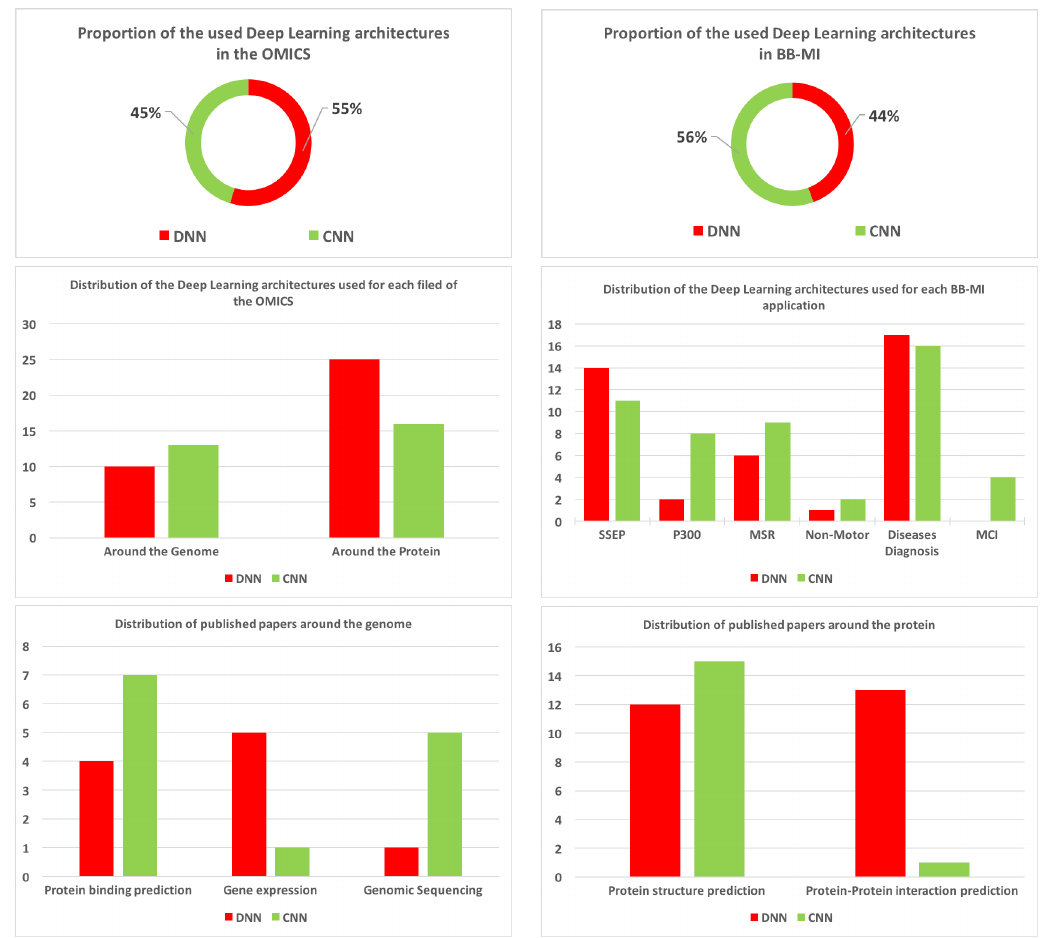
Figure 14. Distribution of the deep learning architectures used in the papers reviewed in this